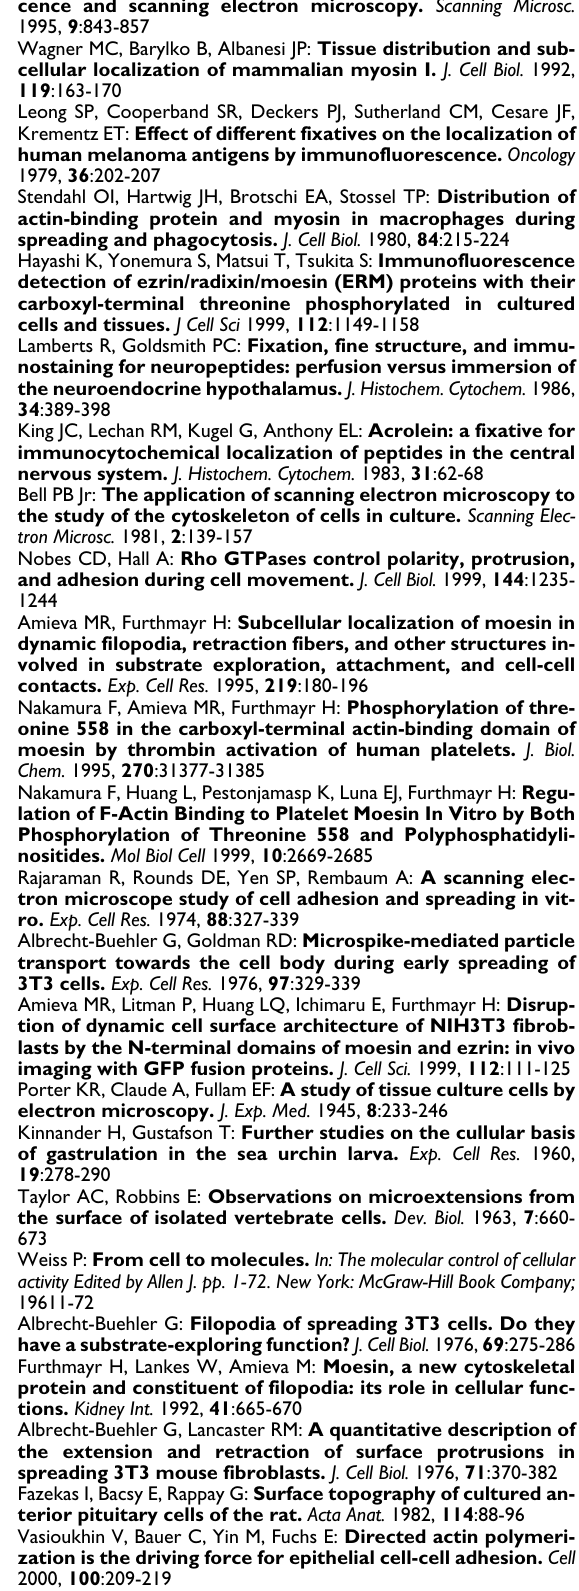
List of abbreviations 1 PIPs, polyphosphoinositides; DOTMAC, dodecyltri- methylammonium chloride; FA, formaldehyde; PFA, paraformaldehyde; SEM, scanning EM; TEM, transmis- sion EM. Other abbreviations are indicated in Table 1.